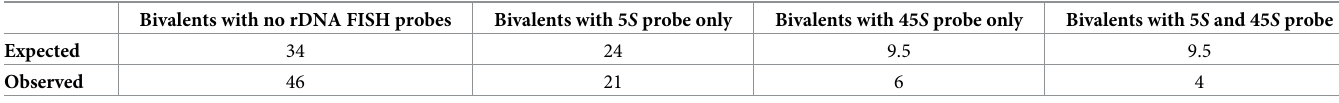
Table 1. Frequencies of expected and observed bivalents that were scored for chiasmata in unstable nuclei labelled with ribosomal DNA FISH probes. Bivalents with no rDNA FISH